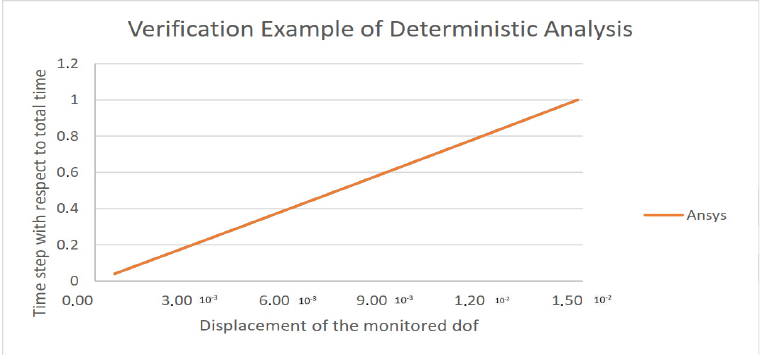
Figure 4. Validation of the method implemented and the Open Source numerical finite element